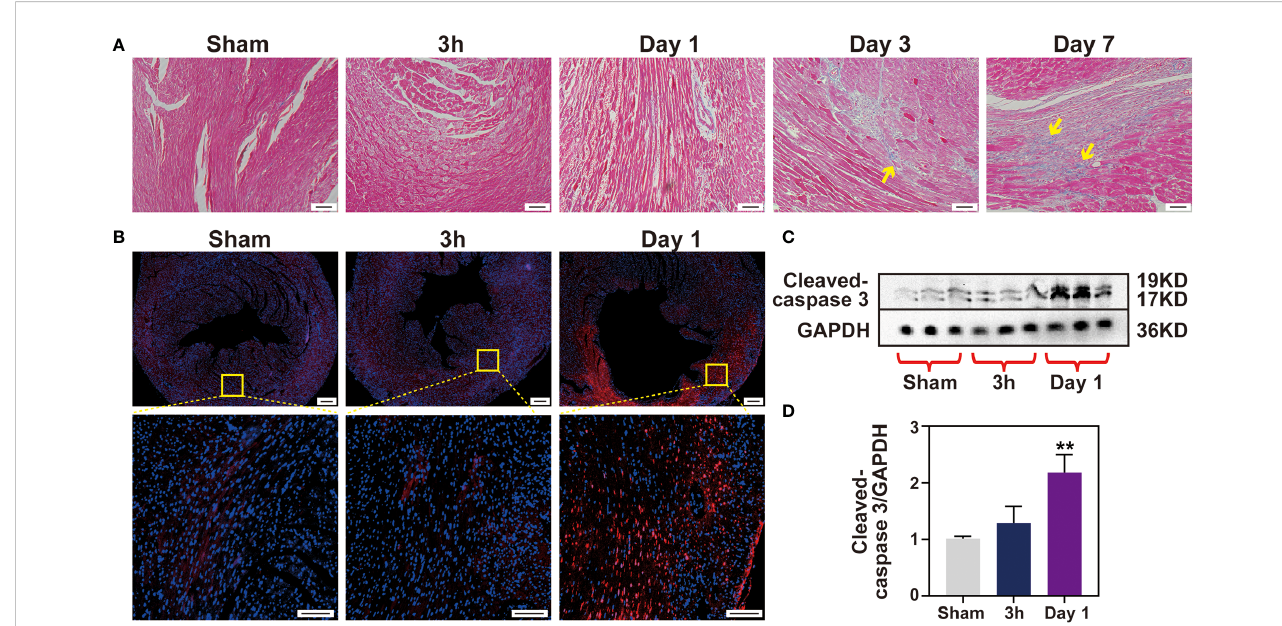
FIGURE 7 No cell apoptosis happens after 3 h IR. (A) , Masson staining of heart sections was performed for each time point (Bar 100 m m). (B) , cell apoptosis was measured by TUNEL assay (Bar =200 m m, 50 m m) and Western blotting (C) in sham group and 3 h, 1 day after IR induction. Quantitative of cleaved- caspase 3 protein expression level (D) , (n = 3). **p < 0.01 VS.